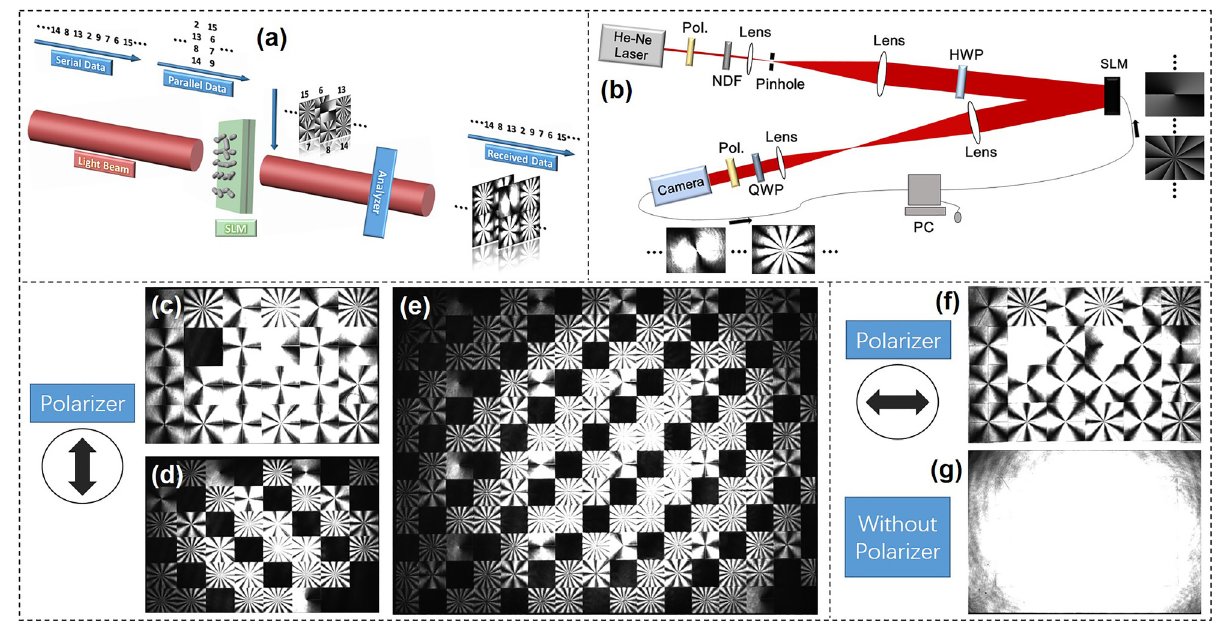
Figure 23: Vector beam array modulation communications. (a) Concept and principle of hexadecimal modulation using vector beam array in a visible-light parallel communication link. (b) Schematic of theexperimentalsetupforhexadecimalmodulationusingvectorbeamarrayinavisible-lightparallelcommunicationlink.Pol.:polarizer;NDF: neutral density filter; HWP: half-wave plate; SLM: spatial light modulation; QWP: quarter-wave plate. Intensity distribution of hexadecimal vector beam arrays analyzed by y -direction polarizer with the elements of (c) 4 × 6, (d) 6 × 8 and (e) 12 × 16 respectively. Power distribution of 4 × 6 array analyzed by x -direction (f) with polarizer and (g) without polarizer [129]. Reprint permission obtained from Random hexadecimal serial data were converted to paral- hexadecimal numbers with error-free data stream trans- lel data according the capacity of the array. As shown in mission [129]. Figure 23a, the serial data were converted to an m × 4 The concept and principle of hexadecimal modulation matrix as the vector beam array carrying 2 × 2 hexadecimal using vector beam array in a visible-light parallel numbers. Every row of thematrix corresponded to a pattern communication link were shown in Figure 23a. The input